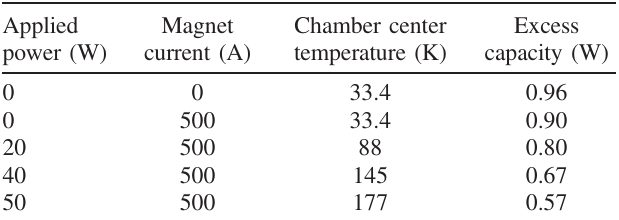
TABLE IV. Observed temperatures of the beam chamber and the magnet during the beam heat load simulation